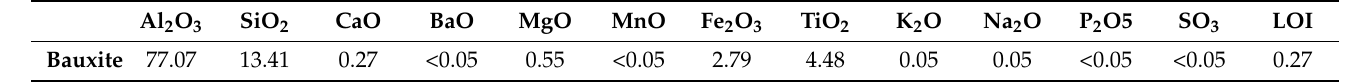
Table 1. Chemical analysis (wt.%) of Bauxite used in this research.